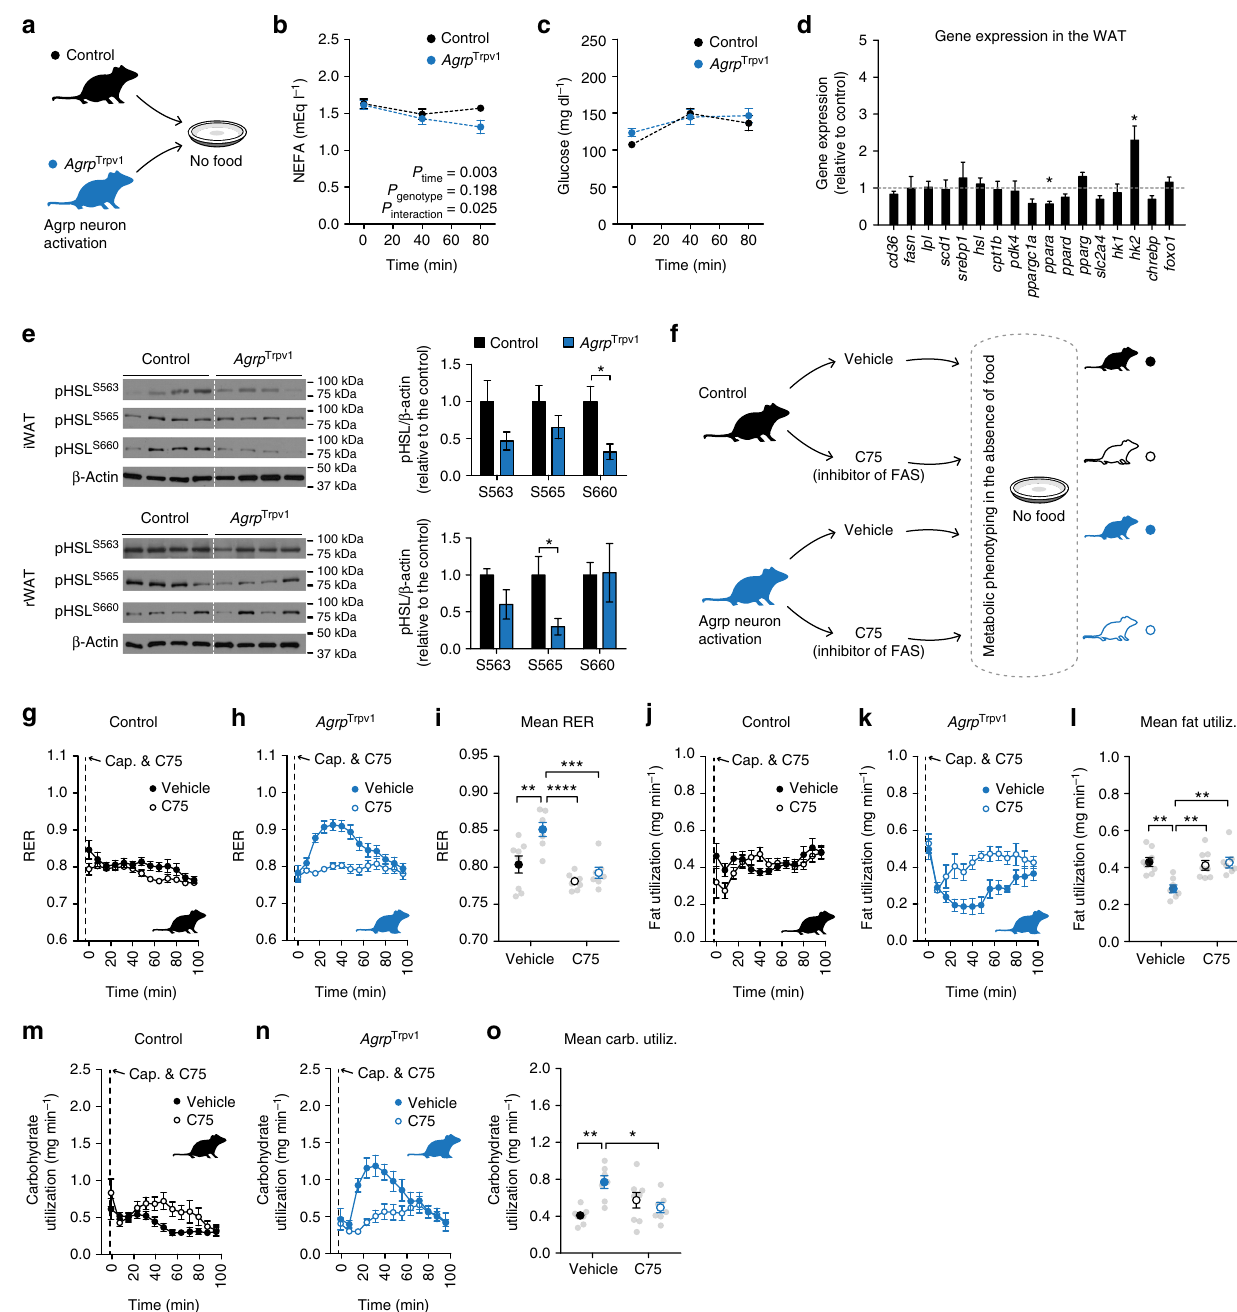
Fig. 4 Agrp neurons promote lipogenesis. a Control (black) and Agrp Trpv1 (blue) mice were injected with capsaicin. b NEFA levels (interaction: F 2,54 = 3.91, P = 0.02; time: F 2,54 = 9.64, P = 0.0003; genotype: F 1,27 = 1.74, P = 0.19; MCT: P 80min = 0.03). c Blood glucose levels (interaction: F 2,54 = 1.47, P = 0.23; time: F 2,54 = 14.6, P < 0.0001; genotype: F 1,27 = 0.67, P = 0.41; MCT: ns). In b and c : control ( n = 15) and Agrp Trpv1 mice ( n = 14). Statistics: two-way analysis of variance (ANOVA) with time as a repeated measure followed by Holm – Sidak ’ s multiple comparisons test (MCT). d Gene expression in the WAT. Data are normalized to control levels (dashed line). Statistics: Student ’ s t -test. * P < 0.05. e Western blotting analysis of phosphorylated HSL in inguinal WAT and retroperitoneal WAT ( n = 4 mice per group). Blots were cropped for clarity. Statistics: Student ’ s t -test. * P < 0.05. f Control and Agrp Trpv1 mice randomly received vehicle or the FAS inhibitor (C75, 10 mg kg − 1 , intraperitoneal (i.p.)) immediately before capsaicin injection. g – i Respiratory exchange ratio (RER) (interaction: F 1,26 = 4.36, P = 0.04; drug: F 1,26 = 22.28, P < 0.0001; genotype: F 1,26 = 11.73, P = 0.002). j – l Fat utilization (interaction: F 1,26 = 9.97, P = 0.04; drug: F 1,26 = 6.00, P = 0.02; genotype: F 1,26 = 6.56, P = 0.01). m – o Carbohydrate utilization: (interaction: F 1,26 = 12.18, P = 0.001; drug: F 1,26 = 0.76, P = 0.38; genotype: F 1,26 = 4.90, P = 0.03). In g – o , statistics: two-way ANOVA on the mean response after drug and capsaicin injection; genotype and drug as factors for the ANOVA. Holm – Sidak ’ s multiple comparisons test (MCT) was used and indicated as * P < 0.05, ** P < 0.01, *** P < 0.001 and **** P < 0.0001. Control mice + vehicle ( n = 8); control mice + C75 ( n = 8); Agrp Trpv1 mice + vehicle ( n = 7); Agrp Trpv1 mice + C75 ( n = 7). Dashed line indicates time of injections. Colored symbols indicate mean ± SEM. Gray symbols indicate individual